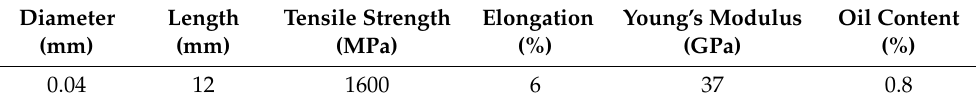
Table 2. Properties of PVA (Polyvinyl alcohol)